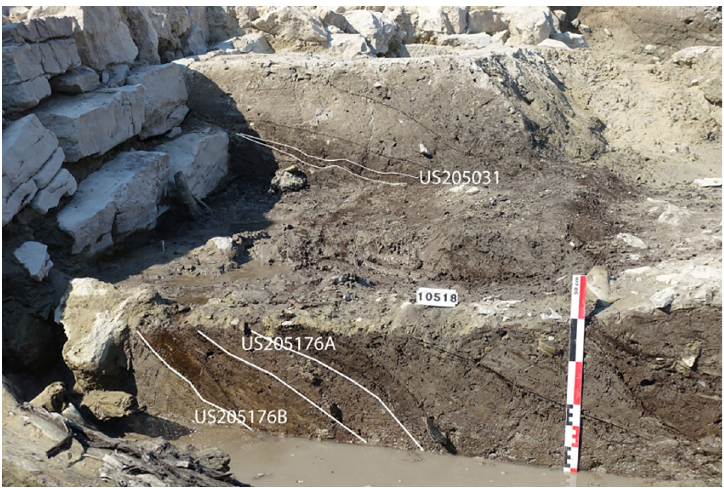
Fig 8. Stratigraphy of two samples that were studied on 2018. (B. Steiner) in zone 205 (US 205176A and B) and compared here with MAS.